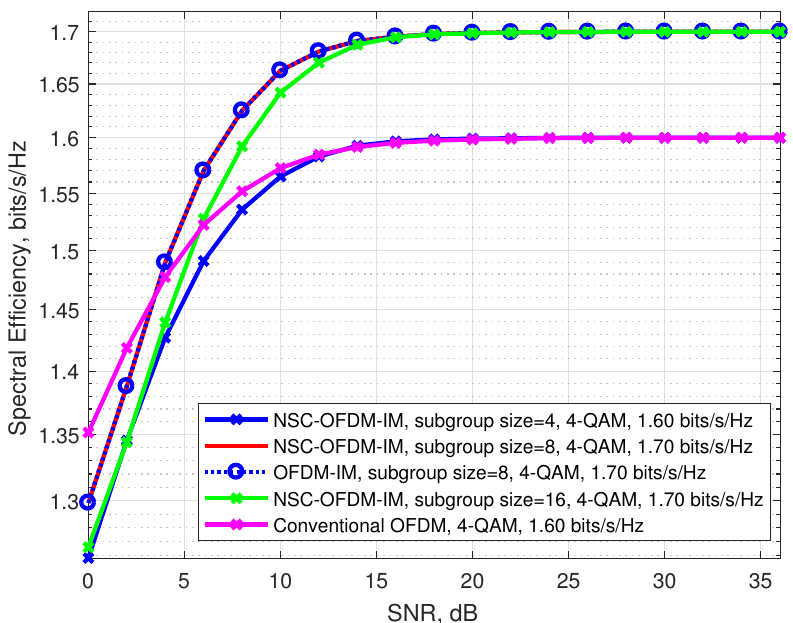
Figure 12. Comparison of the proposed NSC-OFDM-IM with conventional OFDM/OFDM-IM in terms of spectral efficiency, where 4-QAM modulation was adopted.